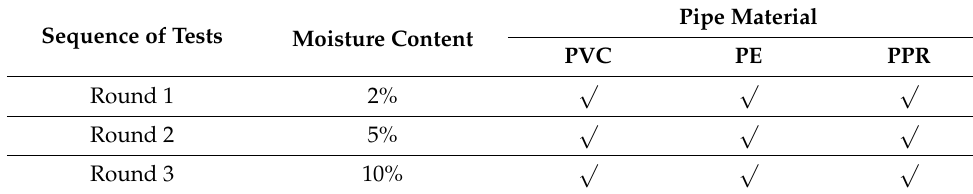
Table 5. Experimental plan.